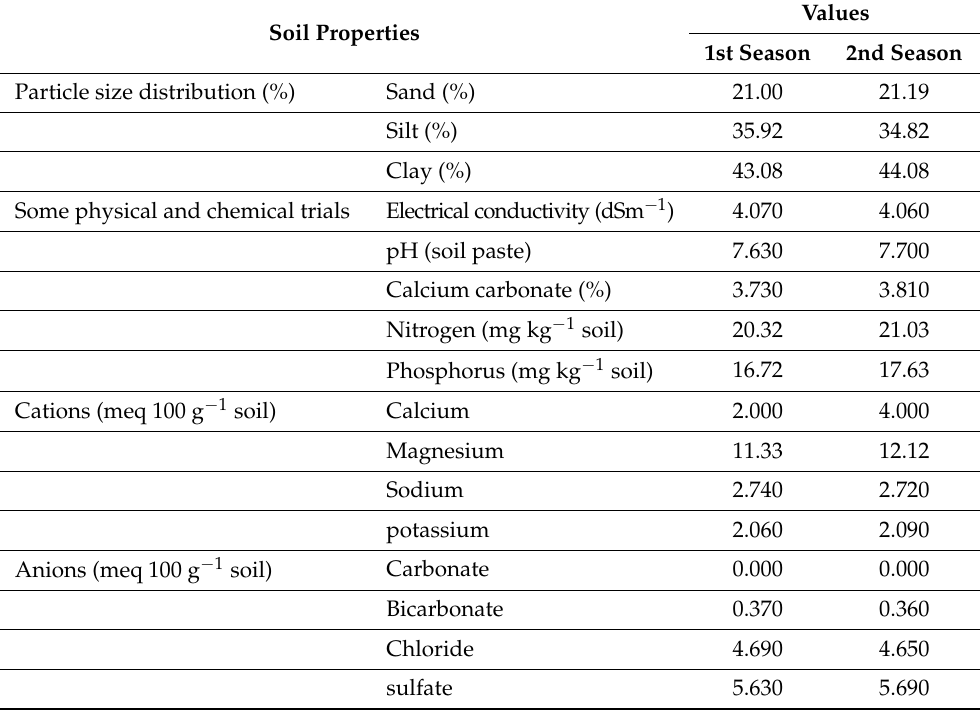
Table 1. Physical and chemical analyses of the experimental soil in two